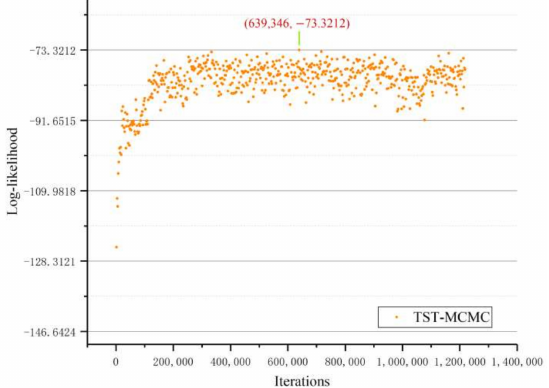
Figure 9. Relationship between the log-likelihood and the number of MCMC iterations.